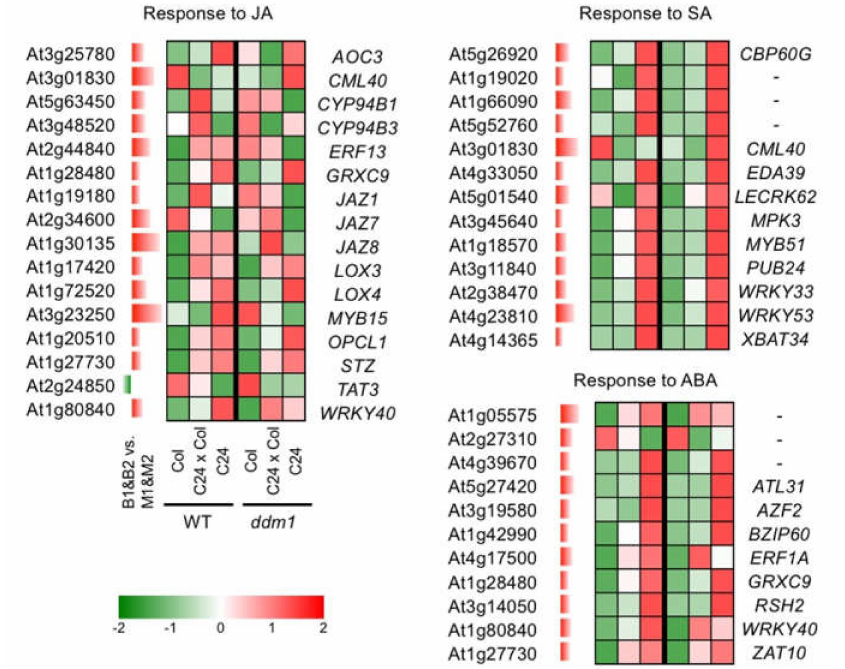
Figure 6. Expression pattern of genes showing B1&B2 > M1&M2 expression. GO terms related to plant hormone response are shown. Expression levels in Col, C24, C24xCol, ddm1 Col, ddm1 C24, and ddm1 C24x ddm1 Col are derived from [27]. Di ff erent red / green colours indicate the fold change (up / down) from the MPV. ABA, abscisic acid; JA, jasmonic acid; SA, salicylic